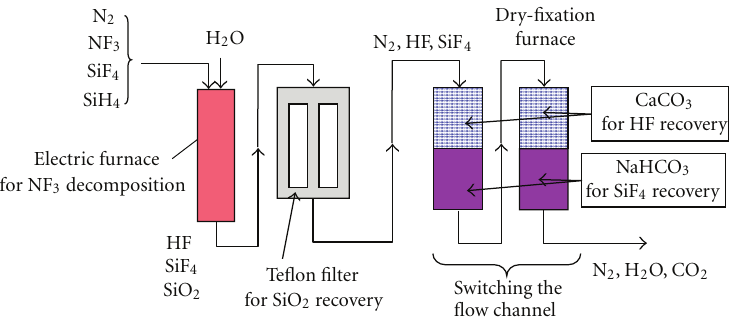
Figure 1: Schematic of the dry-type gas treatment